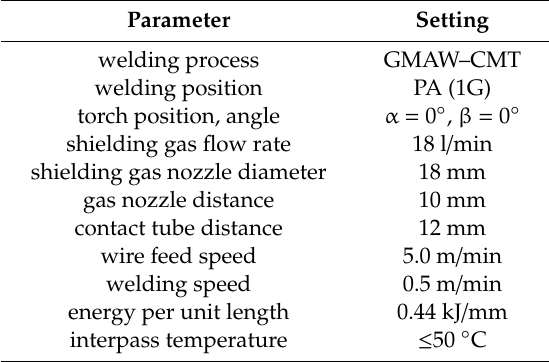
Table 3. Constant process parameters to produce the